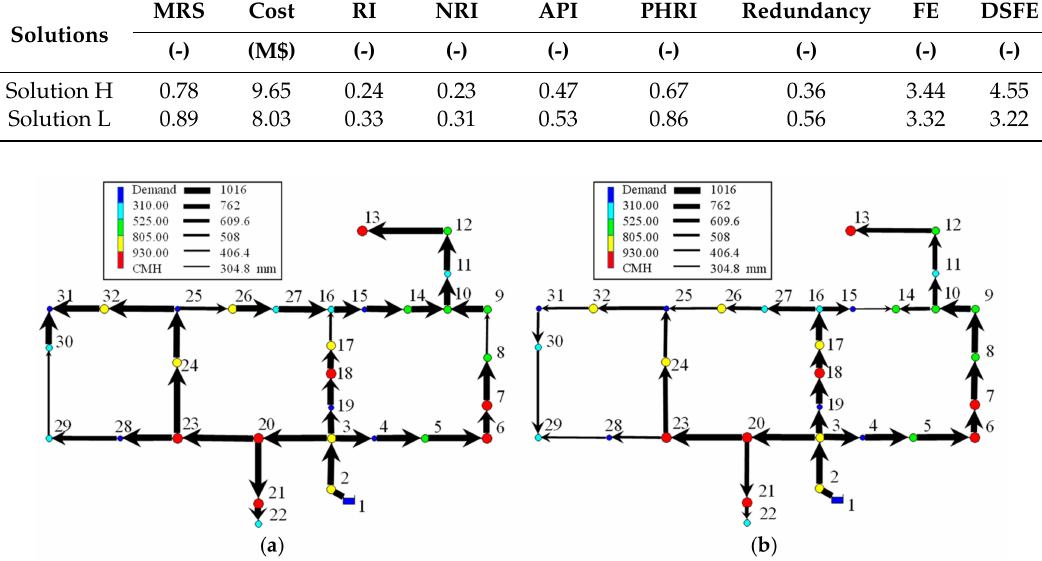
Figure 7. Comparison of two representative solutions found for the HAN problem. ( a ) Solution H with lower reliability; ( b ) Solution L with higher